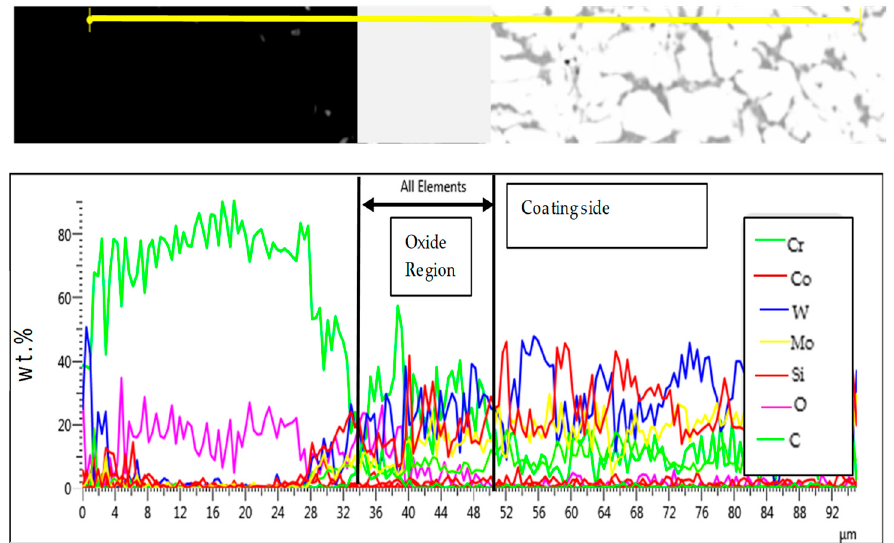
Figure 8. Cross-sectional view and EDS line scan of the T-800/WC specimen after oxidation at t = 120 h.